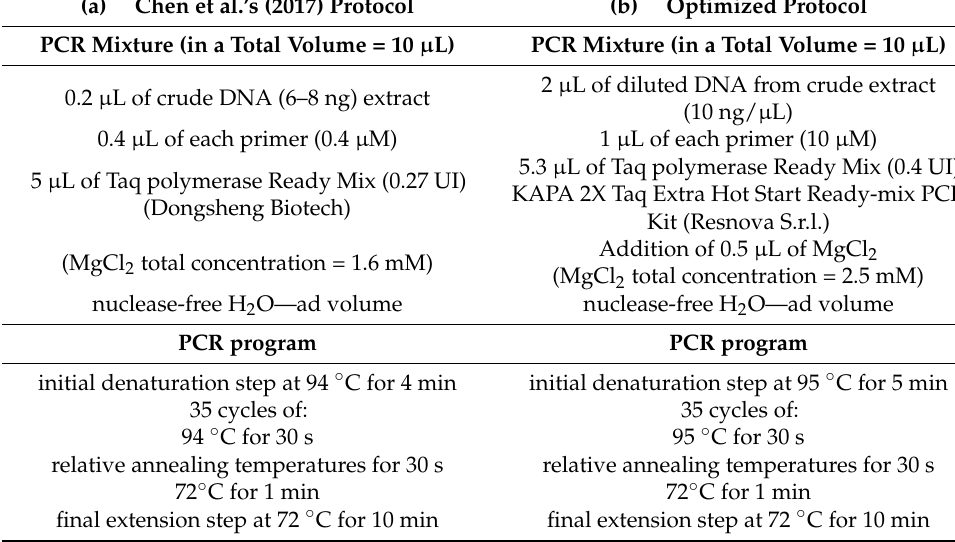
Table 2. Protocol